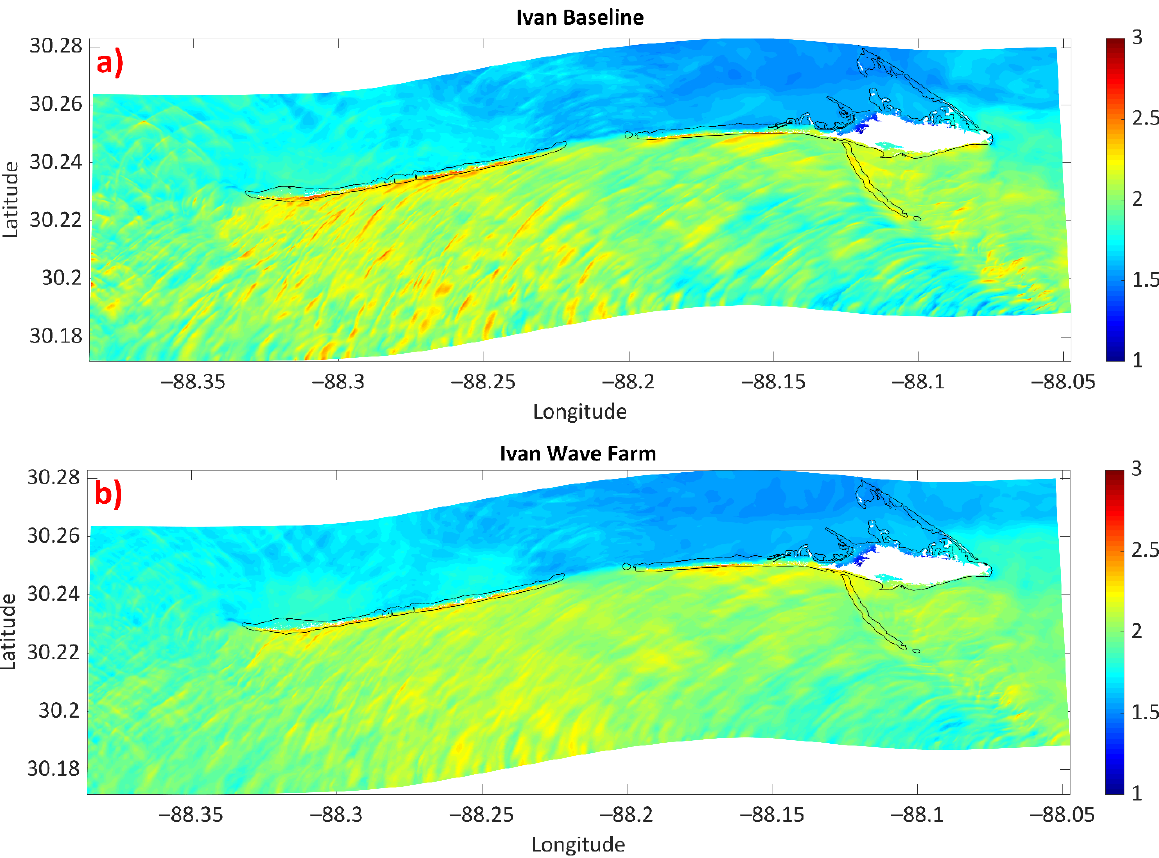
Figure 5. Hurricane IVAN bed levels (BL) and water levels (WL) at the west ( a ), middle ( b ), and east ( c ) transects on Dauphin Island, AL under baseline and wave farm scenarios. Note that the figures are zoomed in for readability. Initial WL is at the zero level for all transects.